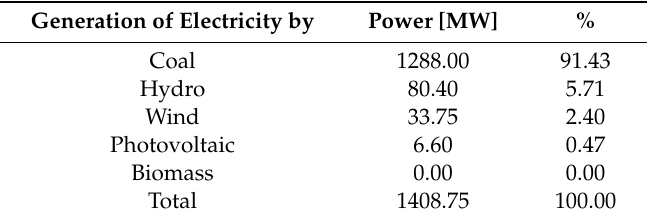
Table 10. Actual power generation capacity in